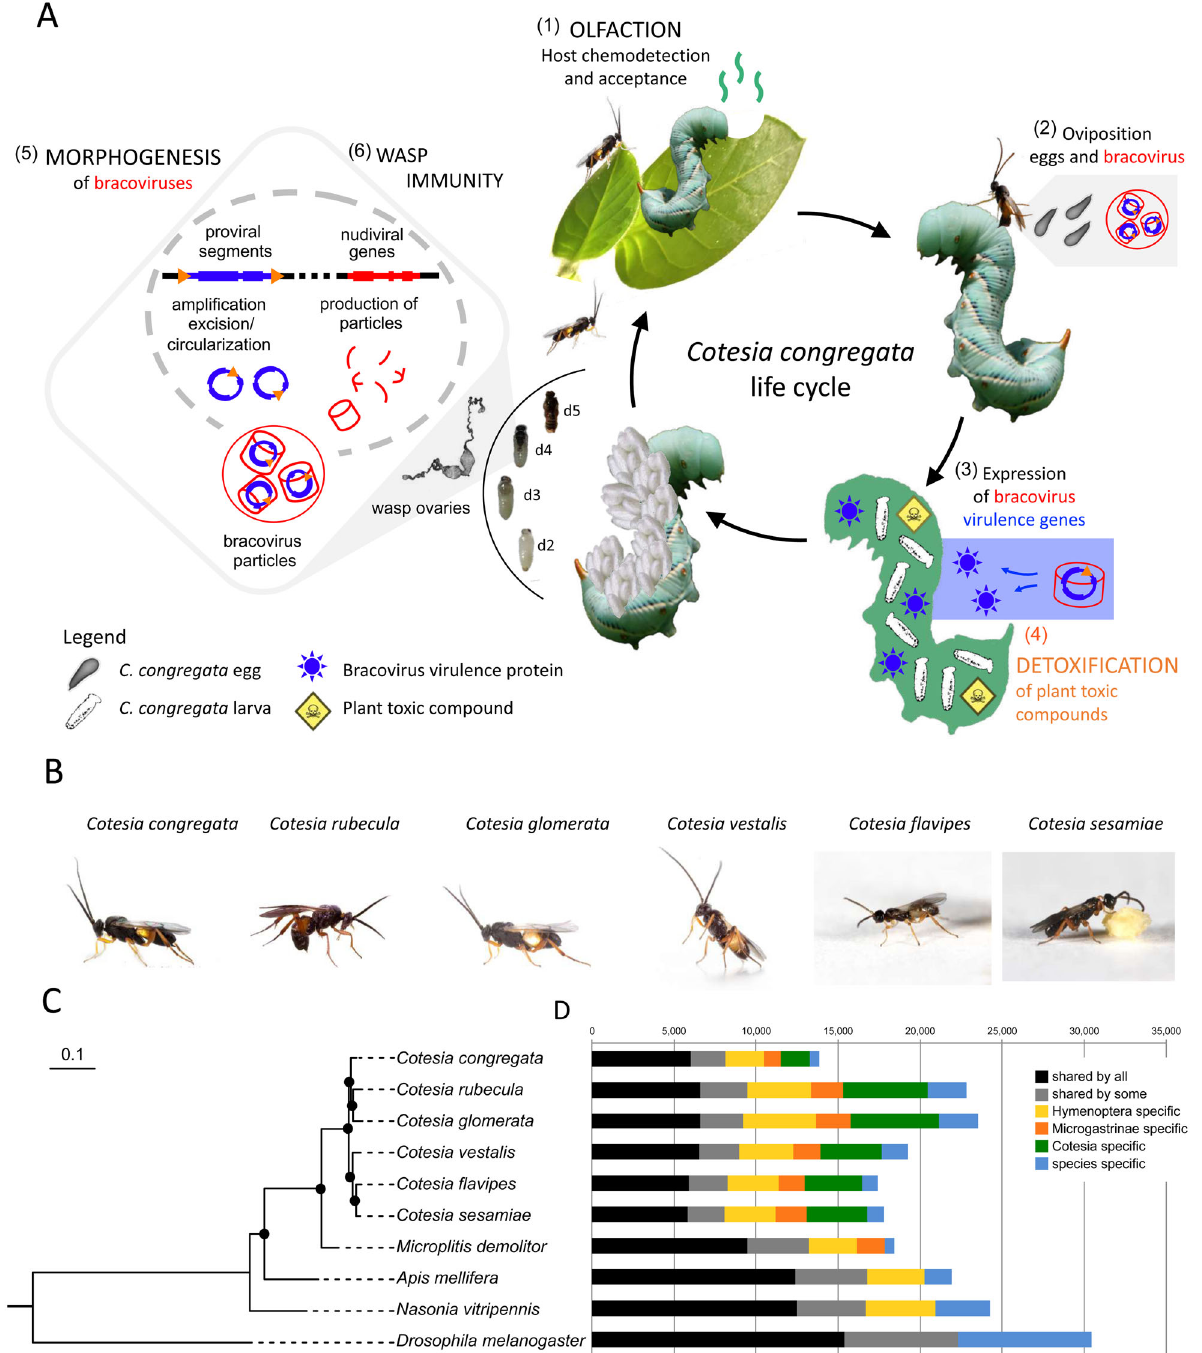
Fig. 1 Cotesia species life cycle, phylogeny, and gene content. A Major traits involved in the parasitoid koinobiont lifestyle and genome content of six Cotesia species. First (1) OLFACTION plays an important role in the detection of the plant (tobacco) attacked by caterpillars and host ( M. sexta ) larvae acceptance by adult wasps ( C. congregata ). Once the host is accepted, the wasp injects its eggs bathed in ovarian fl uid fi lled with bracovirus particles (2). Bracovirus particles infect host cells, from which expression of bracovirus virulence genes (3) alter host immune defenses, allowing wasp larvae development (the eggs laid in the host body would otherwise be engulfed in a cellular sheath of hemocytes). As the host ingests plant toxic compounds, such as nicotine, while feeding, wasp larvae consuming the hemolymph containing these compounds rely on (4) detoxi fi cation to complete their life cycle. However, in these species associated with endogenous viruses the most important trait for parasitism success consists in (5) bracovirus morphogenesis during wasp metamorphosis, using genes originating from a nudivirus ancestrally integrated in the wasp genome. As massive production of virus particles occurs within wasp ovaries, (6) wasp immunity may be induced during particles production; d2, d3, d4, d5 refer to developmental stages of C. congregata larvae 36 . B Pictures of the six Cotesia species sequenced (credit H. M. Smid and R. Copeland). C Phylogeny of these species based on 1058 single-copy orthologous insect genes including the Microgastrinae Microplitis demolitor and outgroups ( N. vitripennis , A. mellifera , and D. melanogaster ). Black dots highlight branches with at least 90% support from maximum- likelihood analysis (1000 bootstraps). D Distribution of shared genes at several phylogenetic levels. Full protein-coding gene sets were included to identify orthologous gene groups. The “ shared by some ” category refers to genes shared by at least nine species among the ten studied. Note that the lower number of genes for C. congregata probably re fl ects the higher quality of the genome assembly obtained. COMMUNICATIONS BIOLOGY| (2021)4:104|https://doi.org/10.1038/s42003-020-01623-8|www.nature.com/commsbio